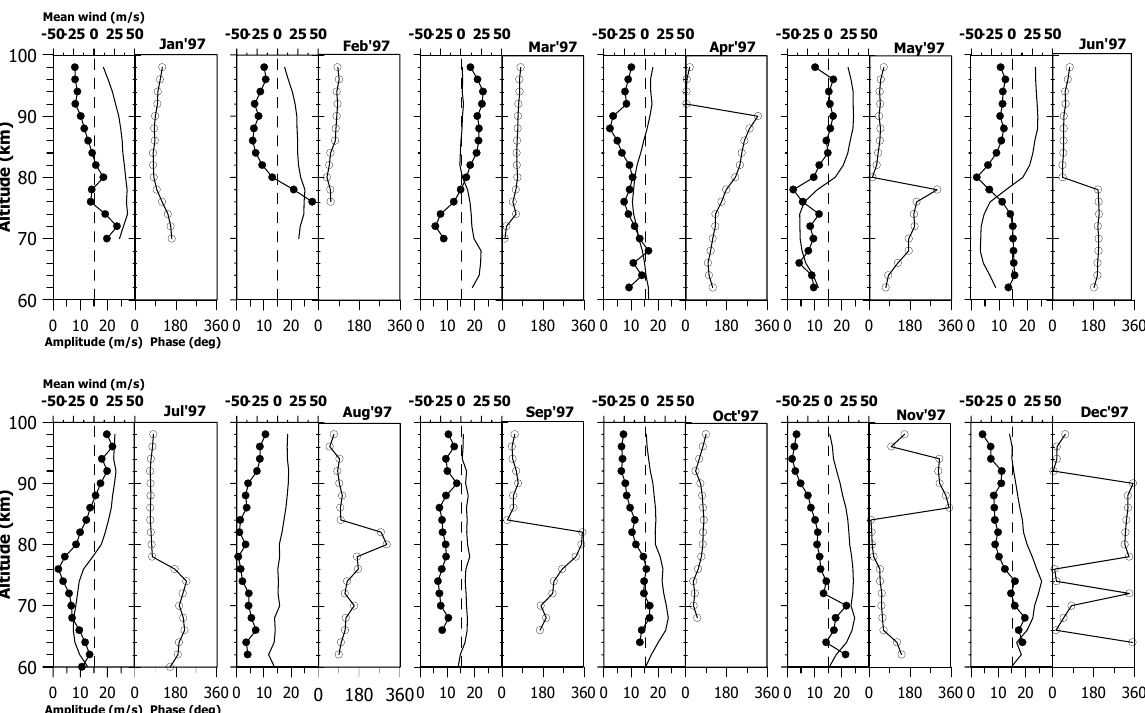
Fig. 5. Height profiles of the monthly amplitudes (solid circle) and phases (open circle) of the 16-day waves at Yamagawa in 1997. The thick solid lines represent the monthly mean zonal